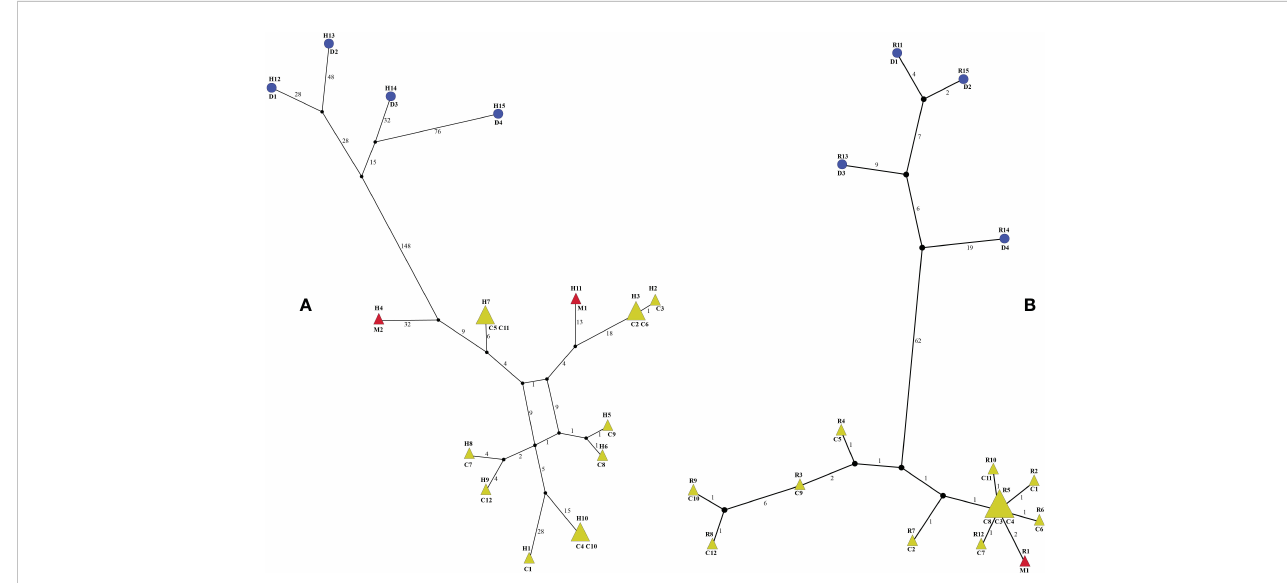
FIGURE 5 Haplotype (A) and ribotype (B) networks of Menispermum . C, D, and M represent M. canadense , M. dauricum , and M. mexicanum , respectively. Sample codes are the same as in Table